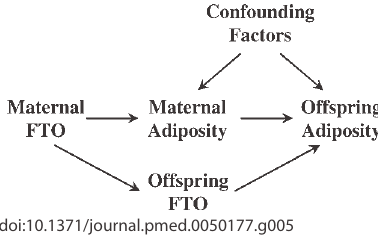
Figure 5. Maternal FTO Only Qualifies as an Instrument Conditional On Offspring